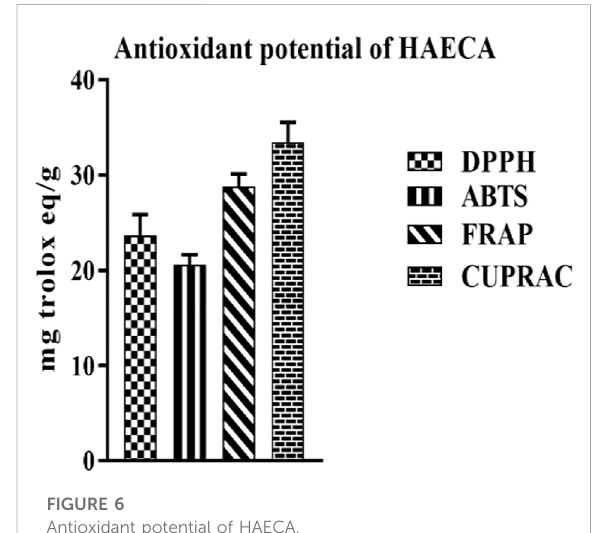
TABLE 4 Effect of HAECA on carrageenan-induced paw edema volume (cm).